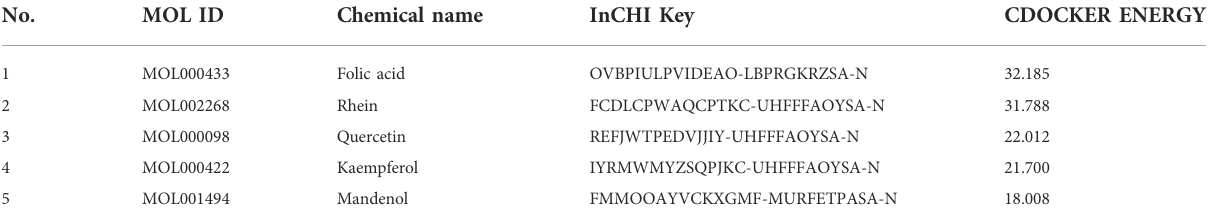
TABLE 3 Top fi ve ingredients scored after docking 4UZQ molecules with 33 compounds. No.